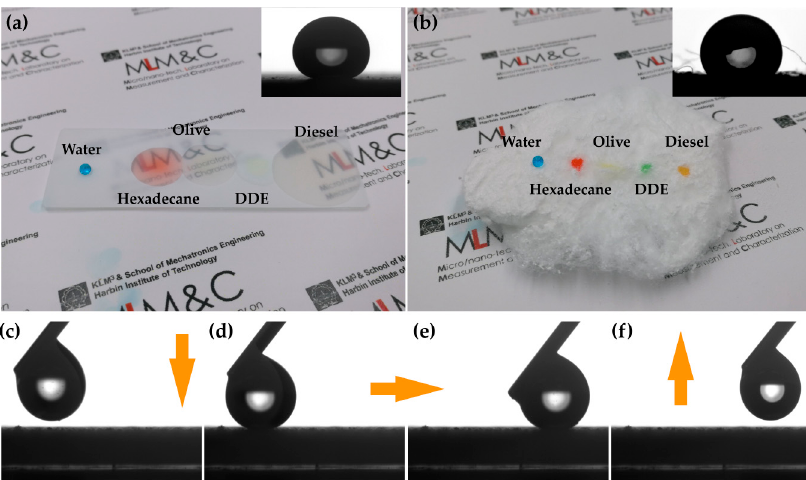
Figure 2. The wettability of water (dyed blue), hexadecane (dyed red), olive oil (yellow), diiodomethane (DDE, dyed green), and diesel (claybank) on ( a ) spray-treated glass and ( b ) paint-treated cotton. Insets show the shapes of the water droplets from a parallel point of view. ( c – f ) Continuous scene of the sliding test on the treated glass; the water droplet was pushed on the surface and slid from left to right before detachment.